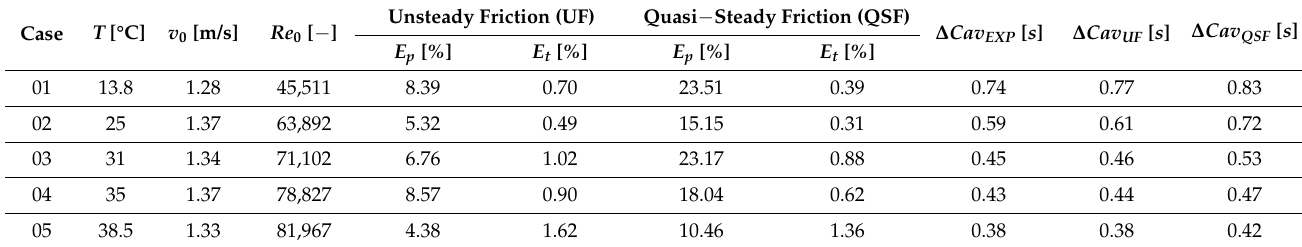
Table 3. Quantitative